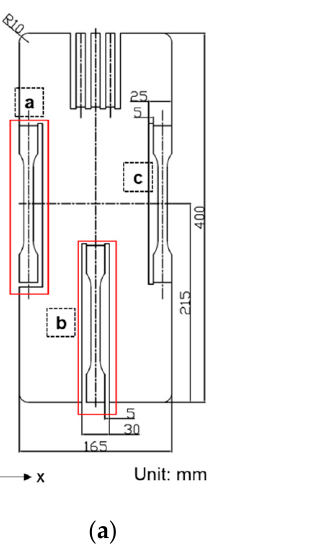
Figure 3. Schematic of tensile samples: ( a ) diagram of the sample designs (ISO 527-2 at a thickness of 3 mm) and ( b ) diagram of the mold cavity of the samples.